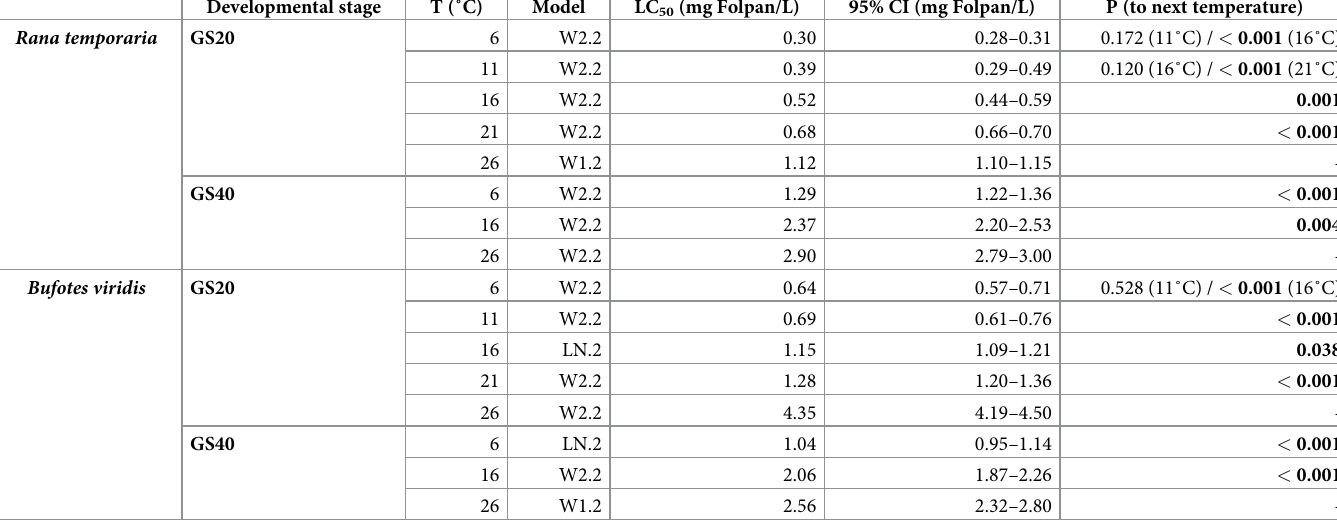
Table 1. Calculated Folpan 1 500 SC 48h-LC 50 values for two developmental stages of R . temporaria and B . viridis at different temperatures with 95% confidence intervals and the used dose-response models. P-values show results from confidence interval overlap tests when testing against the next higher temperature. In case the difference was not significant, it was also tested against the two steps higher temperature. Significant differences after Bonferroni-correction are presented in bold. Developmental